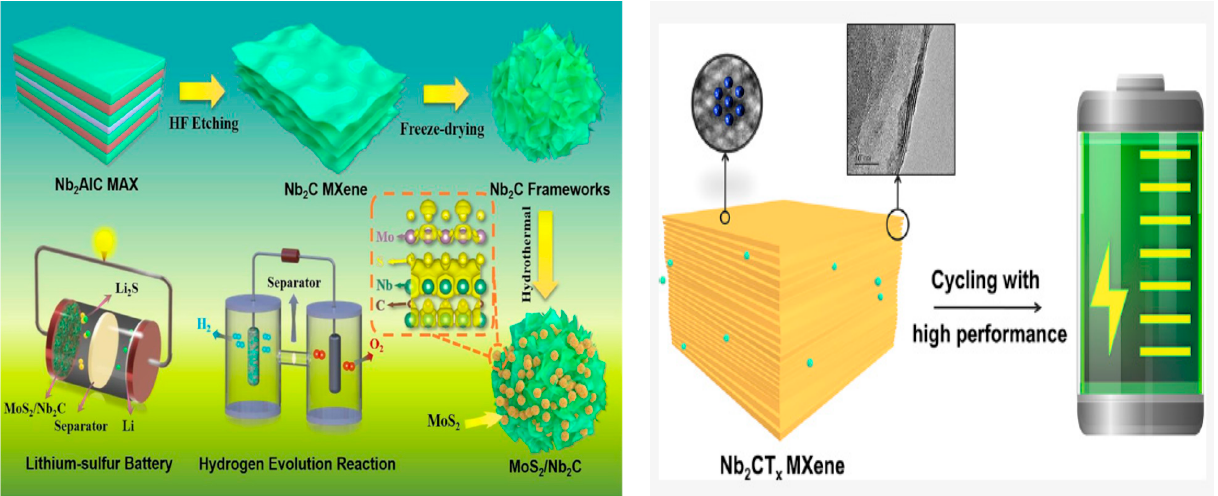
Figure 9. Diagrammatic representation of the fabrication of the MoS 2 /Nb 2 C composite and its applications to the LSB’s cathode and HER electrodes. Reprinted with permission from Ref. [82].